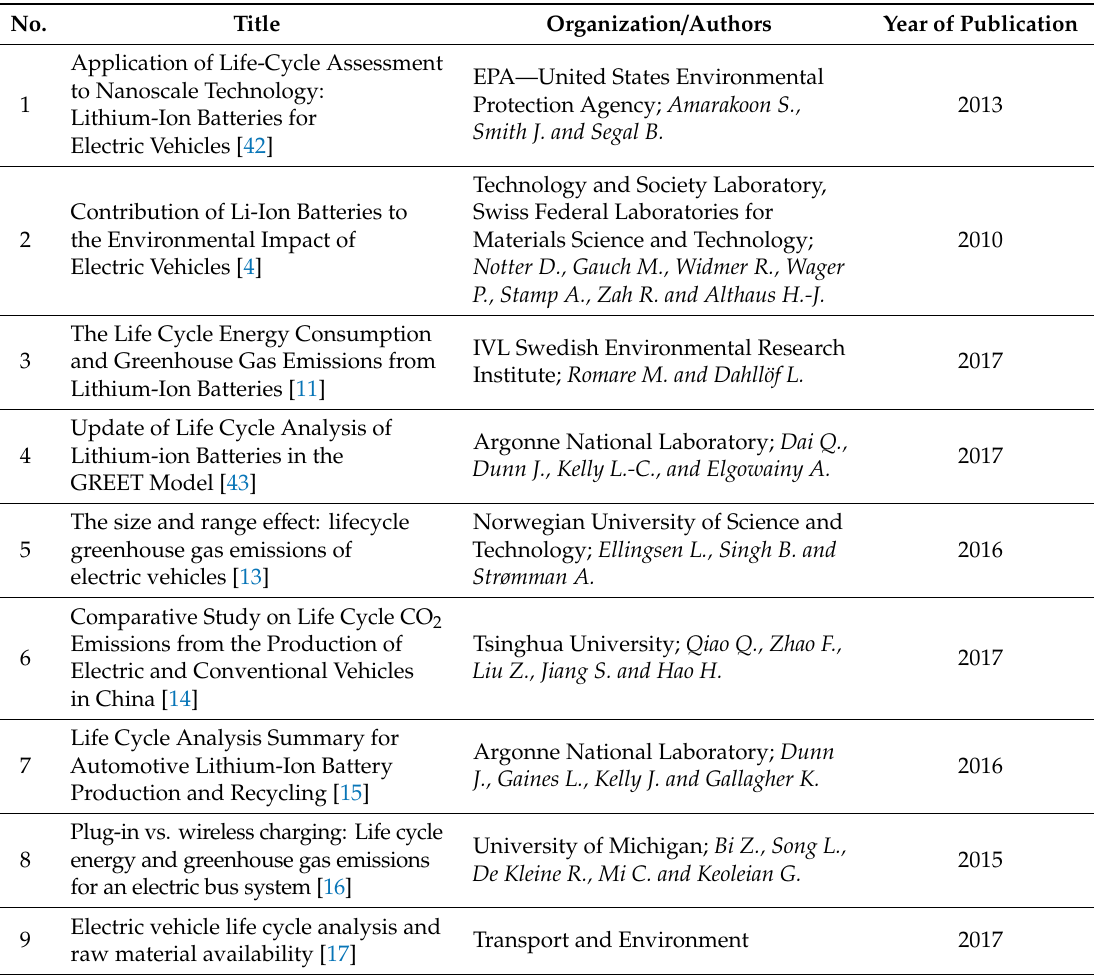
Table A1. Assessed literature in